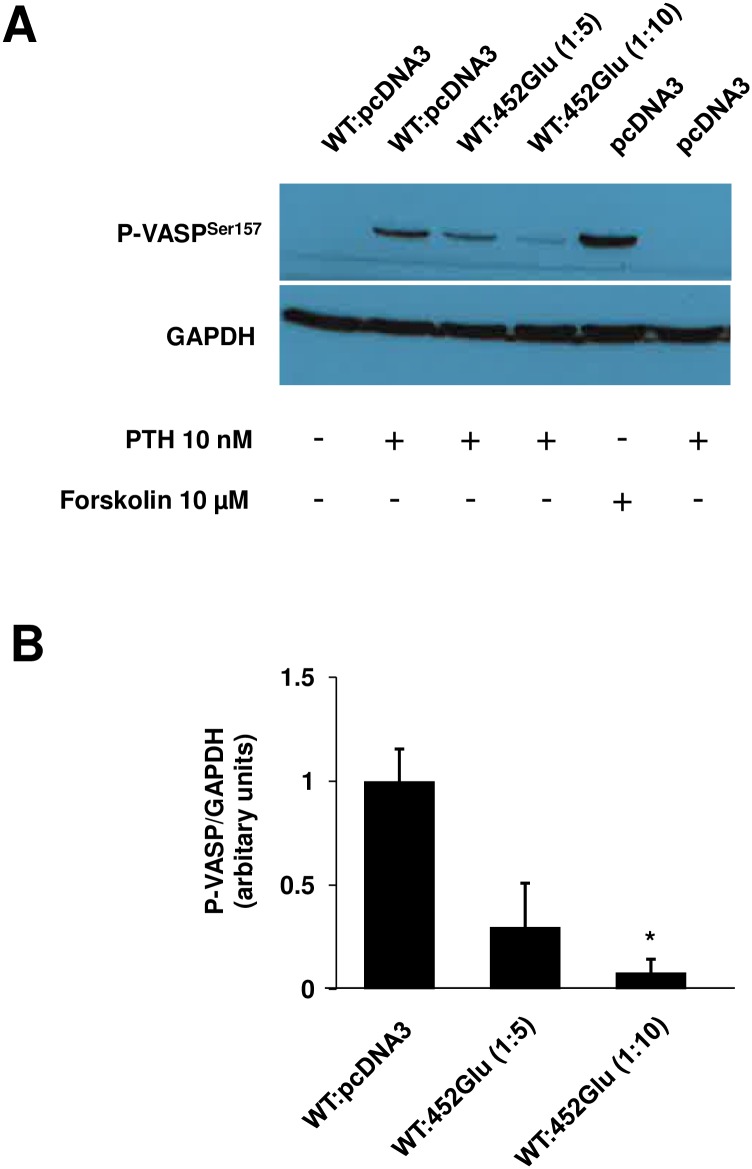
PTH induced VASP phosphorylation in HEK293 cells transfected with various ratio of PTH1R wild type and PTH1R/Gly453Glu mutant plasmids.(A) HEK293 cells were transfected with wild type and PTH1R/Gly452Glu plasmids in a ratio 1:5 (100 ng WT and 500 ng mutant) or 1:10 (100 ng WT and 1μg mutant) as indicated. As controls, pcDNA transfected cells and cells co-transfected with WT (100 ng) and pcDNA3 (1 μg) were used. 48 hours after transfection, cells were stimulated as indicated and lysed for Western immunoblots against P-VASP and GAPDH (loading control). Shown are representative blots of 3 independent experiments. (B) Bar graphs show quantification of phospho-VASP calculated with ImageJ software (n = 3). **p<0.05.